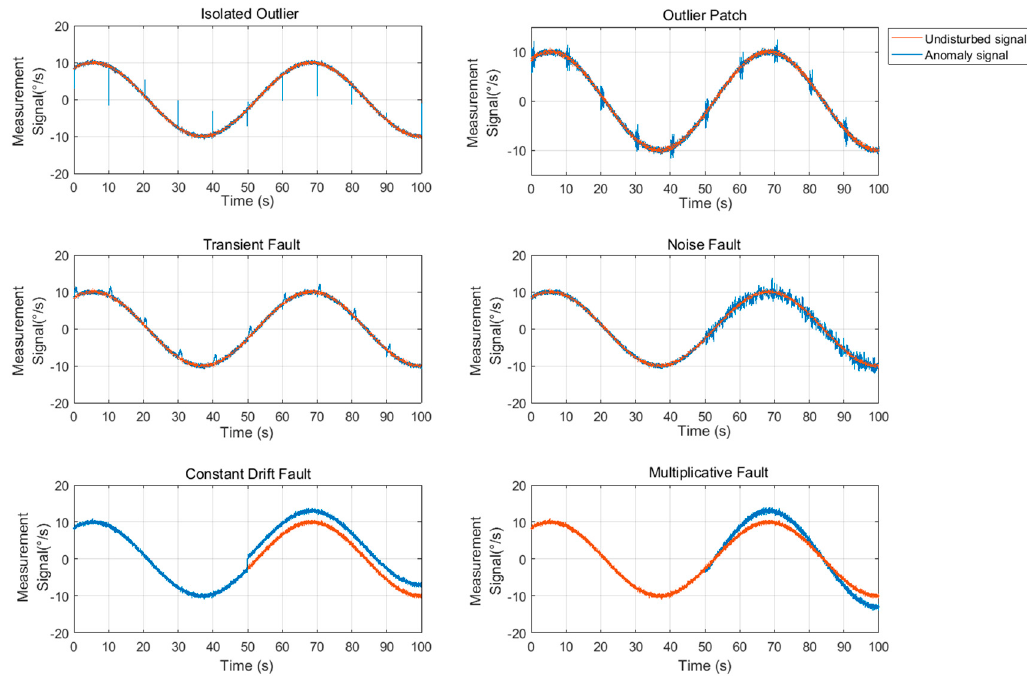
Figure 4. Gyro simulation signals.